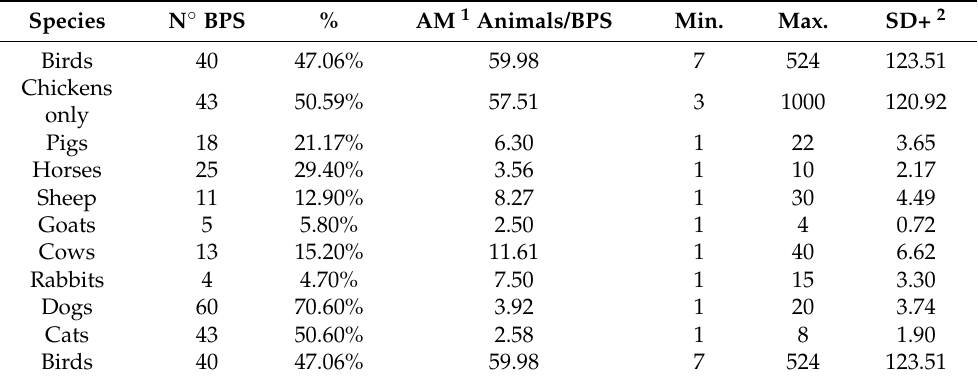
Table 2. Descriptive characterization of species kept in BPS in the Metropolitana